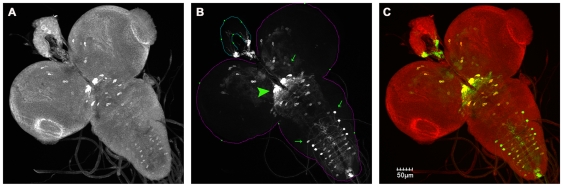
Overlap of DdcGAL4 and Ddc labeled cells in larval brains.Three-dimensional projections of confocal Z-stacks of a wild-type Drosophila 3rd instar larval brain (A–C) expressing mCD8GFP with DdcGAL4 and immunostained with an anti-Ddc antibody (A) and anti-GFP antibody (B). A majority of DdcGAL4::UASmCD8GFP labeled cells overlap with those stained with the Ddc antibody, though there are some cells in both cases that do not overlap (green arrows in B). These do not appear in the region of the IPCs. Green arrowhead in (B) indicates DdcGAL4::UASmCD8GFP expression in Ddc stained cells in the sub-esophageal ganglia that lie in close proximity to IPC projections. Scale bars A–C, 50 µm.